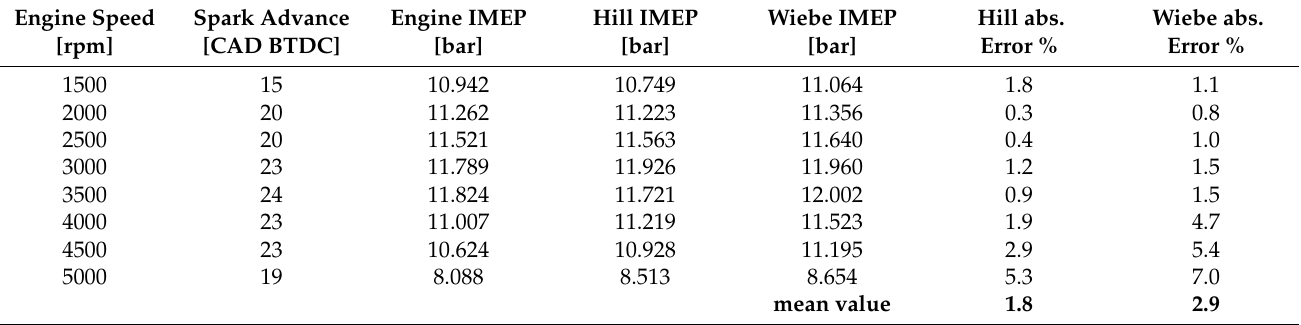
Table 5. Experimental and simulated IMEP with absolute prediction errors (40% NG; MAP = 1.2 bar).